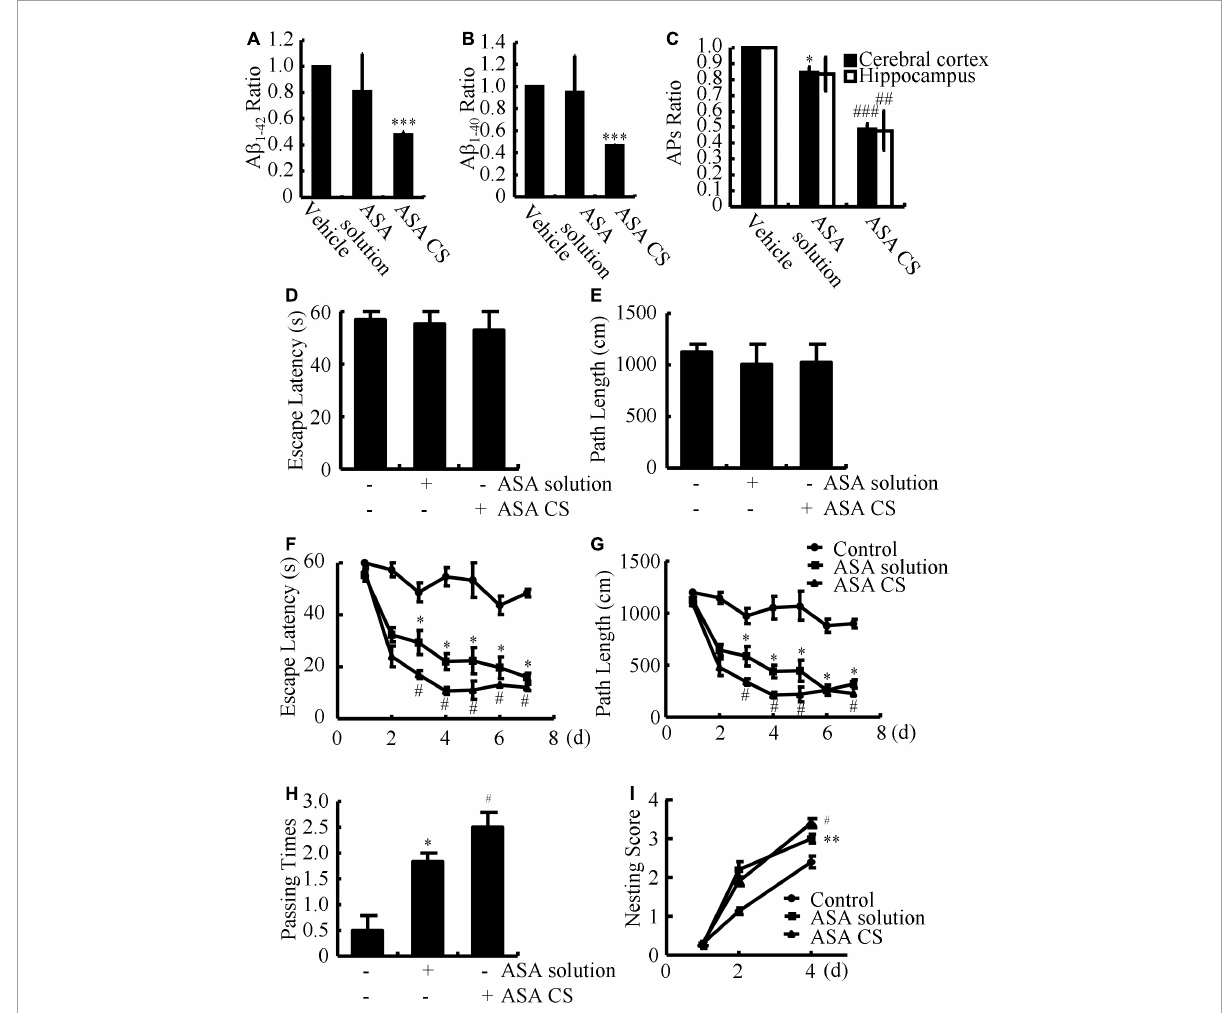
FIGURE1 ASA-CS shows better effects on improving the cognitive decline of APP/PS1 Tg mice than that of ASA solution via disrupting the production and deposition of A β . (A–I) APP/PS1 Tg mice were intranasally administered with ASA solution or ASA CS (0.2 mg/kg/d) for 3 months. (A,B) The contents of A β 1 − 40 and A β 1 − 42 in the cerebral cortex and hippocampus were determined by ELISA. (C) The ratio of APs in the cerebral cortex and hippocampus of APP/PS1 Tg mice was determined using IHC. (D,E) Escape latency and path length of mice in the visible